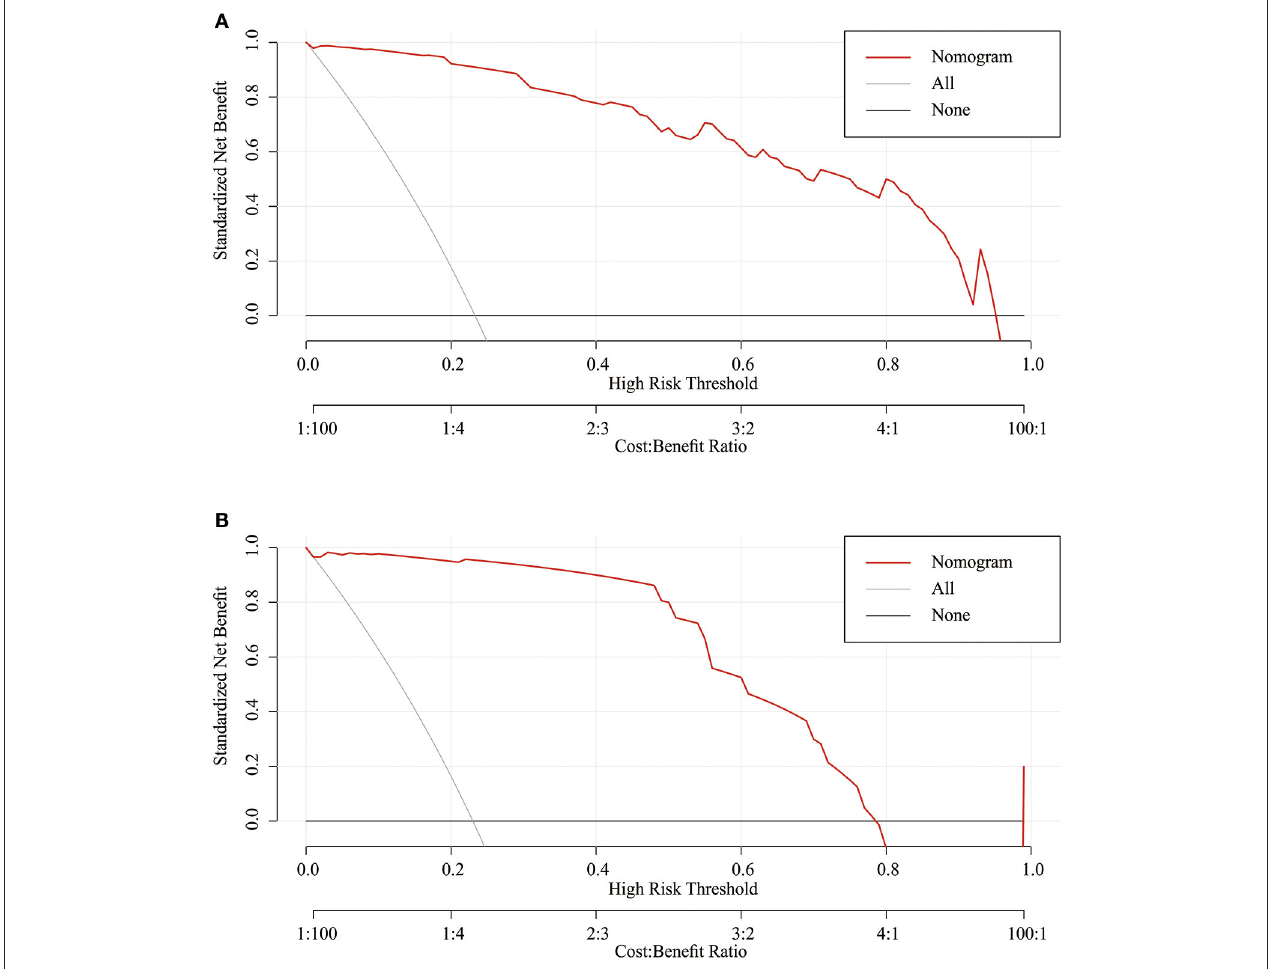
FIGURE 5 | Decision curve analysis of the nomogram in the training set (A) and validation set (B) . The red line displays the net benefit of our model. The gray line assumes that all patients develop dysphagia. The black line assumes that no patients develop dysphagia.